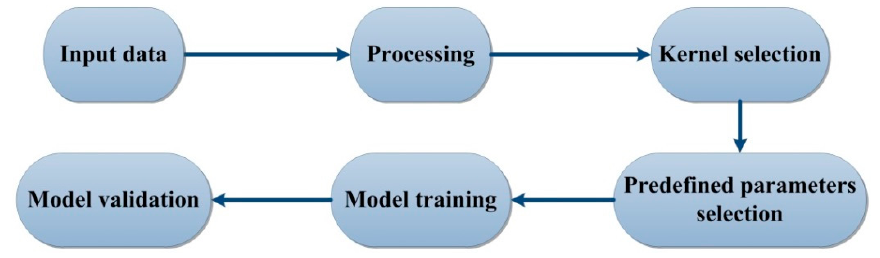
Figure 2. Schematic configuration of the SVR model.